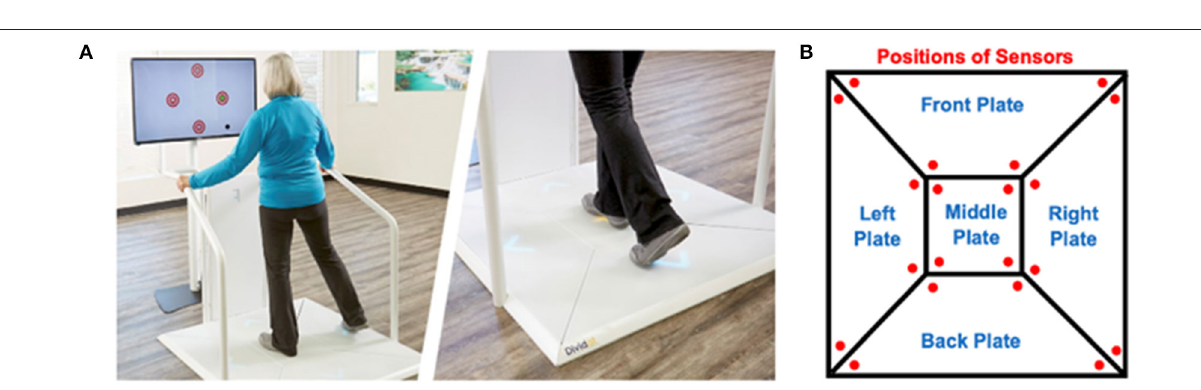
“without object manipulation vs. with object manipulation” were not distinguished within the adapted taxonomy for this